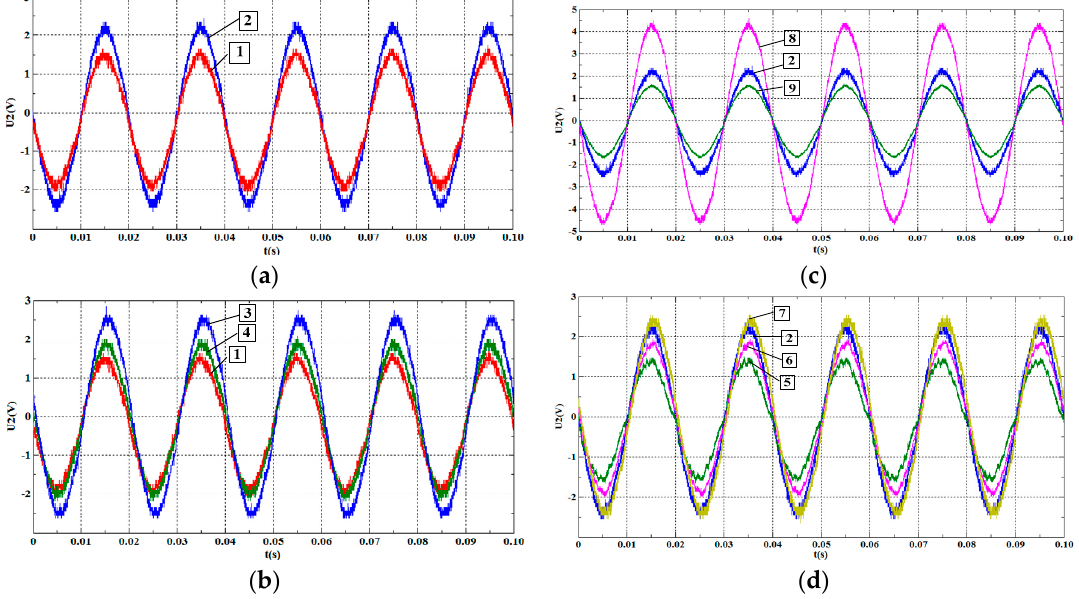
Figure 10. Experimental results: ( a ) Load voltage contrast between 1 and 2 of the energy harvesting device; ( b ) Load voltage contrast between 1, 3 and 4 of the energy harvesting device; ( c ) Load voltage contrast between 2, 8 and 9 of the energy harvesting device; ( d ) Load voltage contrast between 2, 5, 6 and 7 of the energy harvesting device.